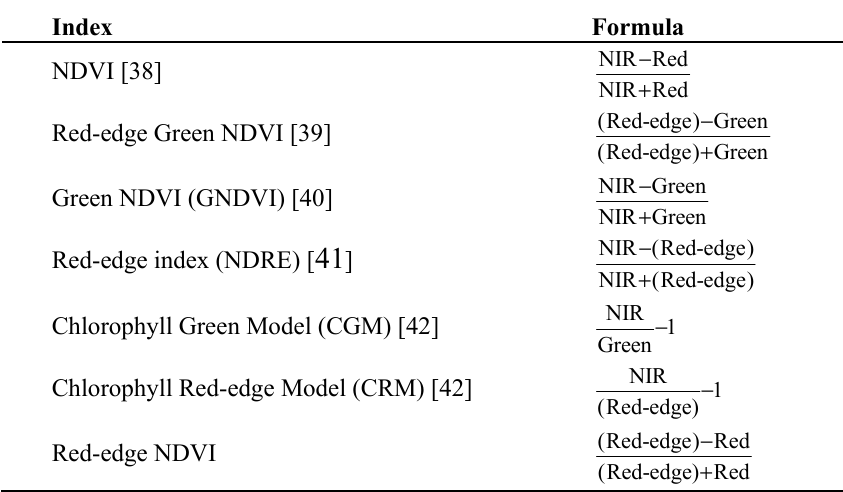
Table 2. Vegetation indices calculated from the RapidEye